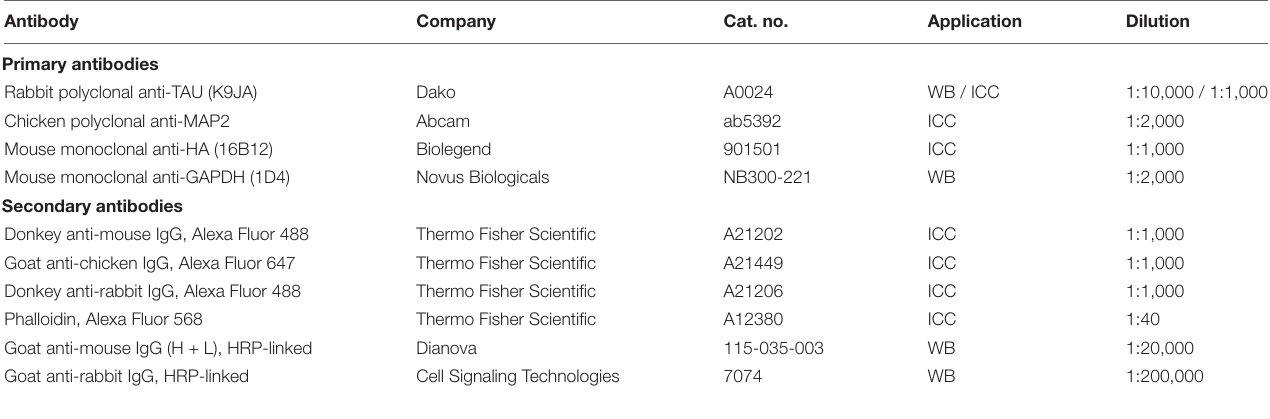
TABLE 1 | Antibodies used in this study. Antibody